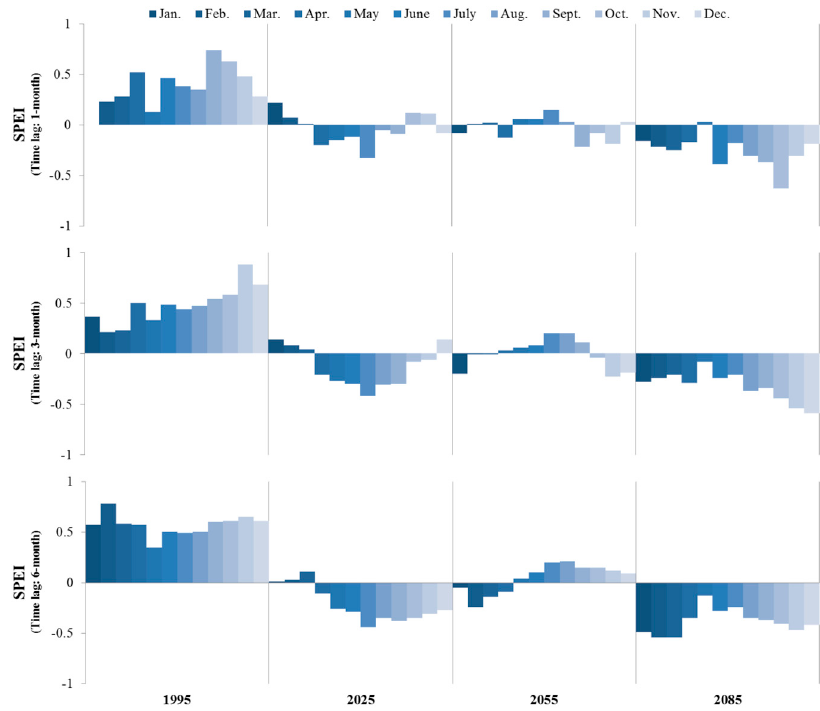
Figure 8. Mean SPEI on multiple seasonal timescales.